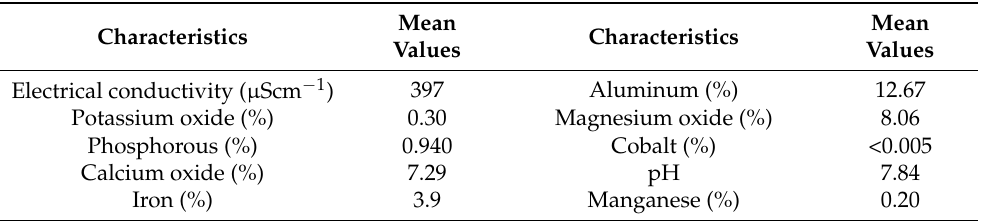
Table 2. Physico-chemical analysis of soil in CNEA (cid:48) s experimental plot farm for the cultivation of Phaseolus vulgaris